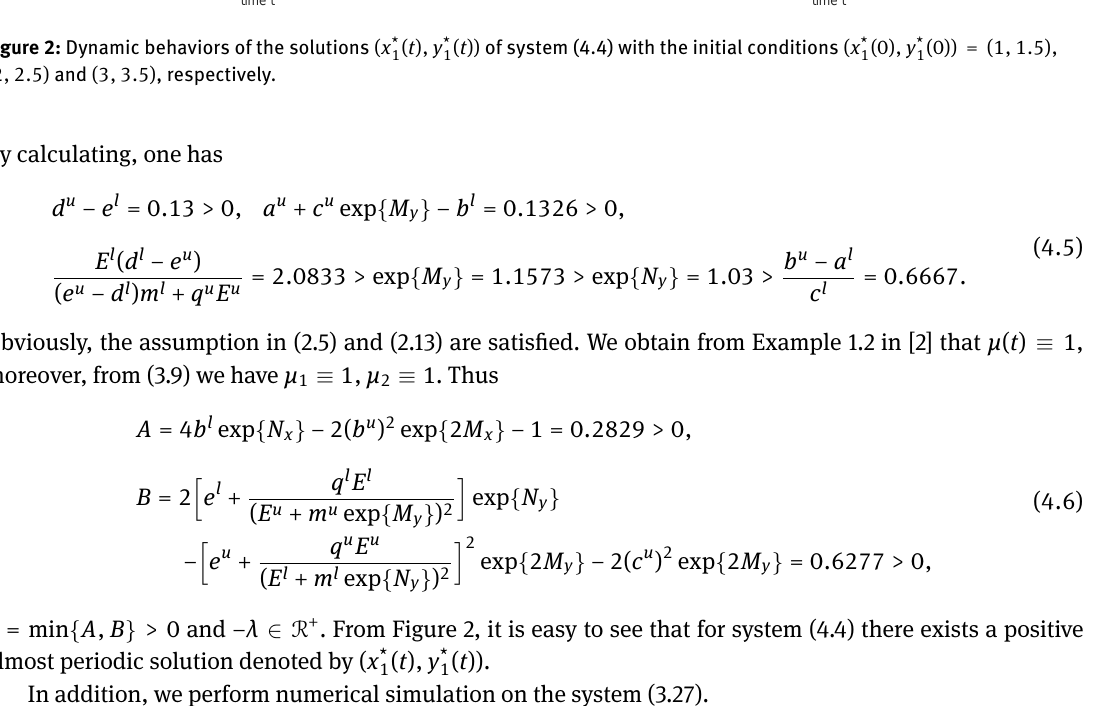
( t ), y * ( t )) of system (4.4) with the initial conditions ( x * 1 1